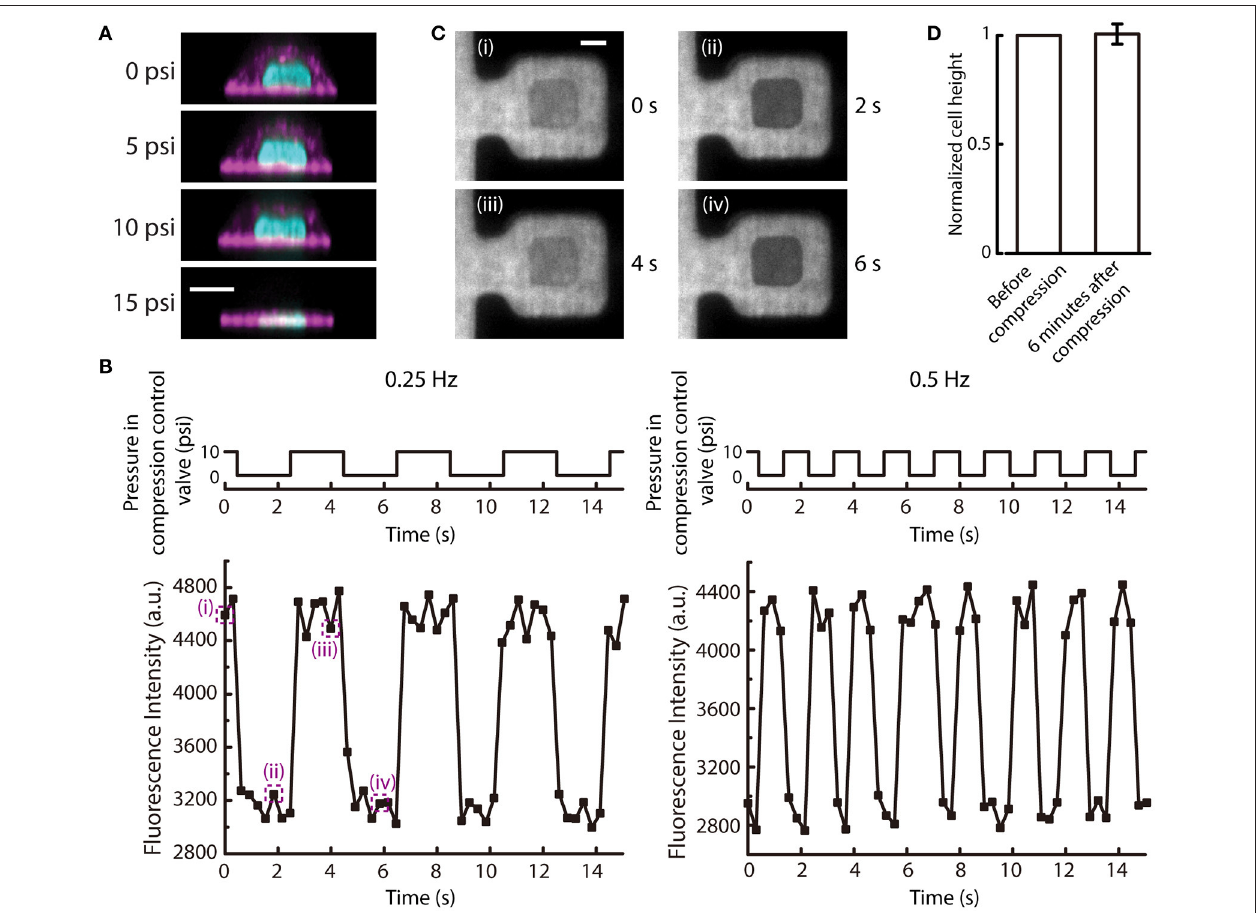
FIGURE 6 | Cyclic deflection of the membrane and compression of cells. (A) Reconstructed side view images of a MCF-10A cell at different applied pressures to compression control valve. Cyan: DNA; Magenta: actin. Scale bar = 10 µ m. (B) (Top) The applied cyclic pressure in the compression control valve over time at 0.25Hz (left) and 0.5Hz (right). (Bottom) The measured fluorescence intensity of the rhodamine succinimidyl dye at the middle of the compression chamber over time when the compression control valves were pressurized at the corresponding frequencies. (C) Fluorescence images of the compression chamber at different time points, as indicated in (B) . Scale bar = 20 µ m. (D) The normalized cell height before and 6min after 6-min cyclic compression alternating between 10 and 15 psi at 0.5Hz ( n = 6). Error bar denotes the standard error of mean. No statistical significance by t